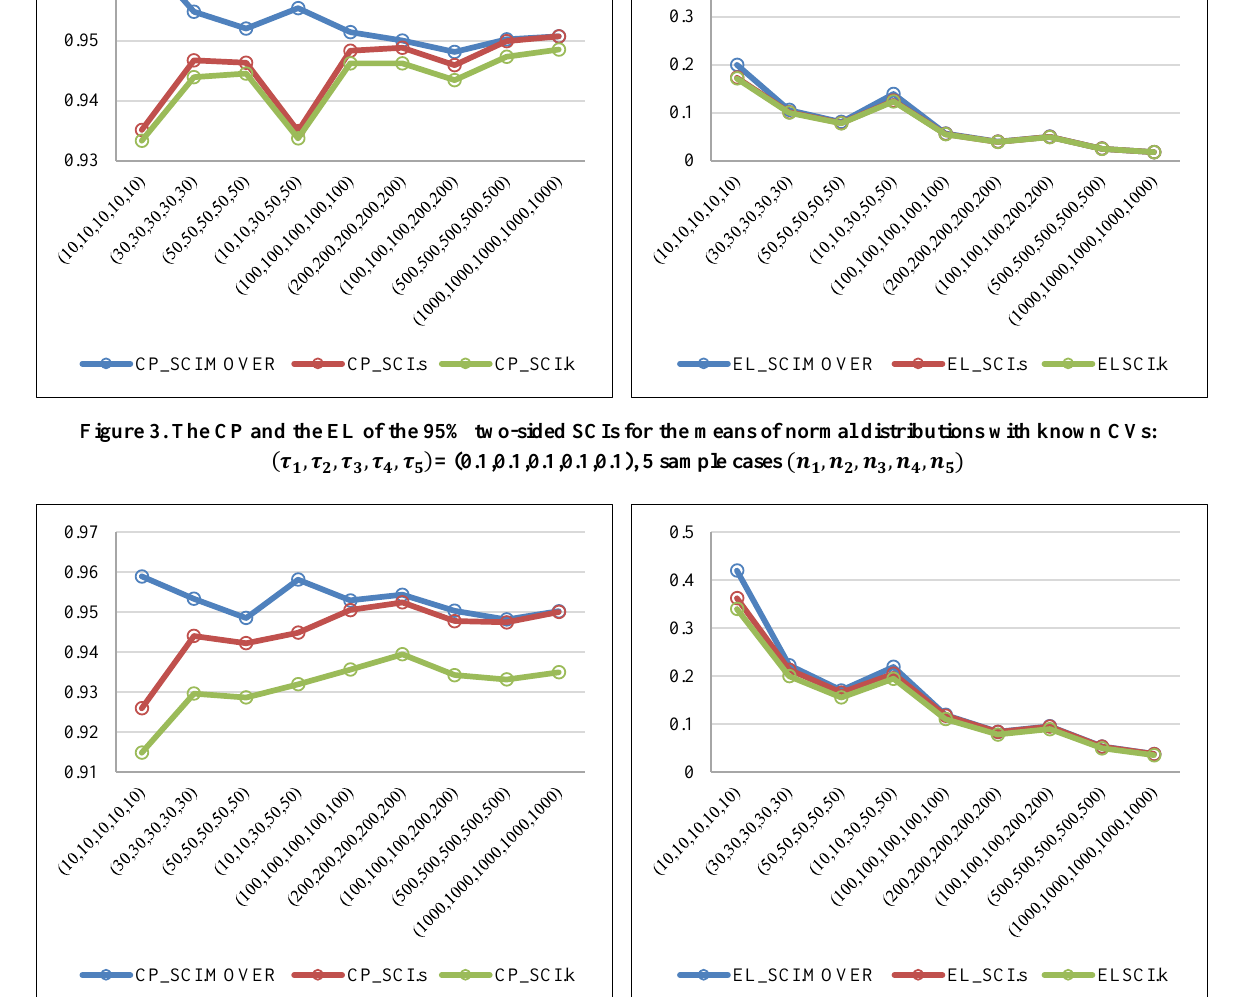
Figure 4. The CP and the EL of the 95% two-sided SCIs for the means of normal distributions with known CVs: (𝝉 ) = (0.1,0.1,0.2,0.3,0.3), 5 sample cases (𝒏 𝟏 , 𝝉 𝟐 , 𝝉 𝟑 , 𝝉 𝟒 , 𝝉 𝟓